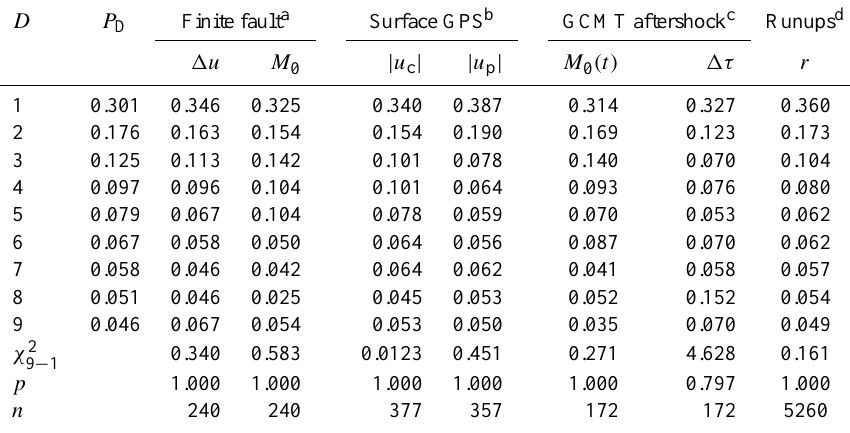
Table 1. Benford’s law probabilities P D in conjunction with the first digit distribution of various parameters related to the source of the Tohoku earthquake and related phenomena. D P D Finite fault